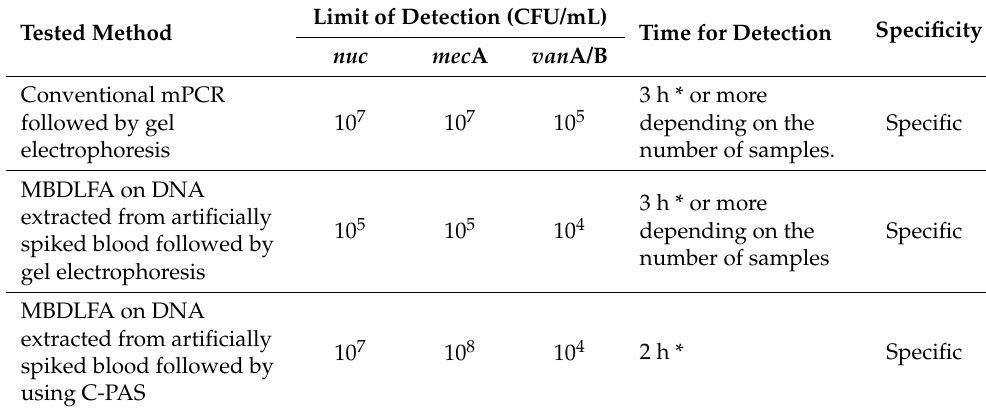
Table 2. Limit of detection, time for detection, and specificity of the tested methods. Tested Method